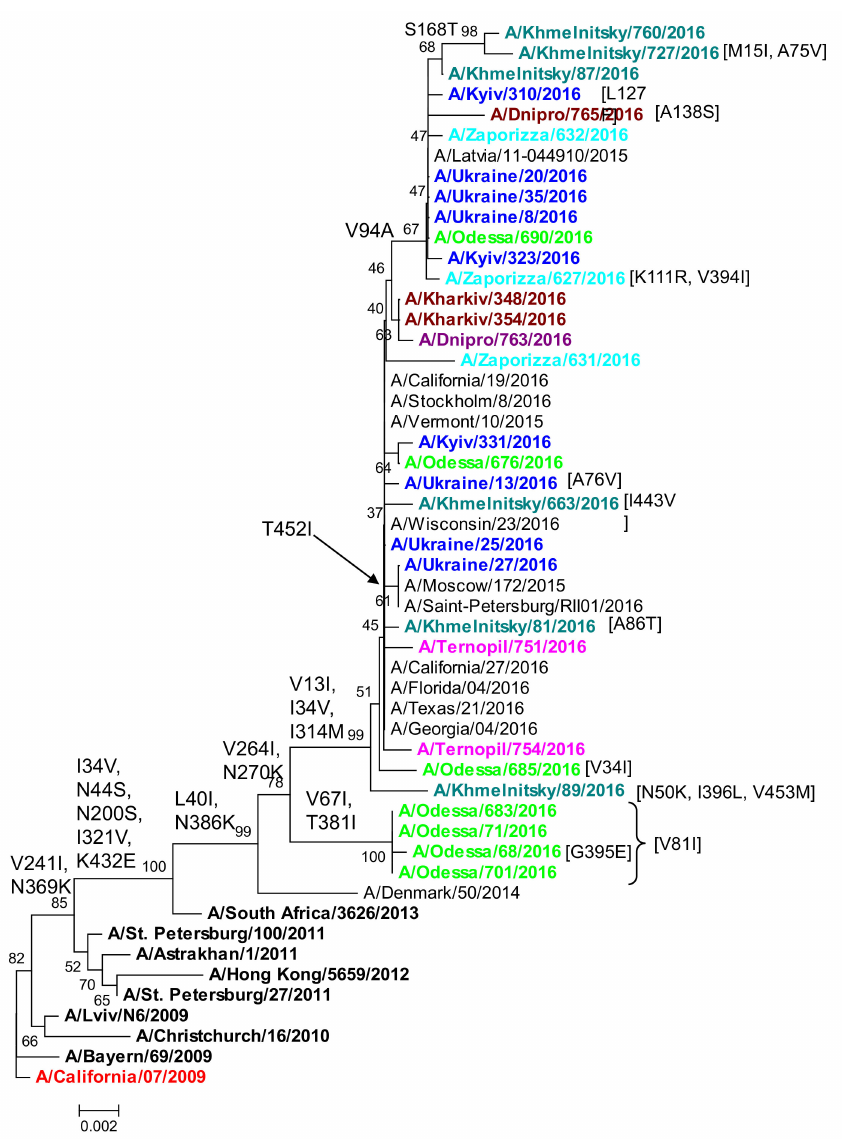
Figure 5. Phylogenetic comparison of A(H1N1)pdm09 influenza virus NA from the 2015/16 season. NA nucleotide sequences were used to build a tree by NJ method, Kimura 2-parameter model, with 1000 bootstrap replications. Amino acid variations are indicated; strains from Ukraine are colored; reference strains are black, and the vaccine strain is